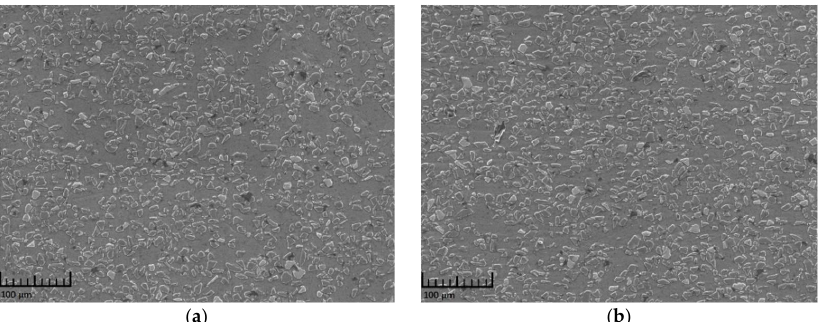
Figure 1. Particle distribution in the as-prepared PRMMCs. ( a ) SEM image of the cross section; ( b ) SEM image of the longitudinal